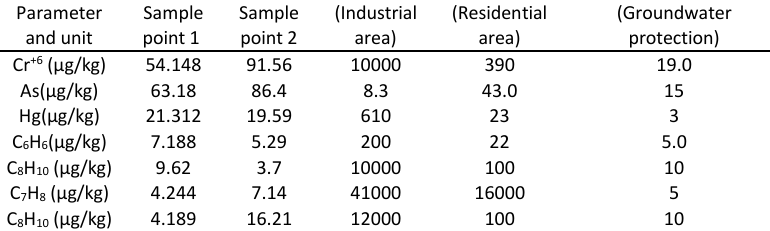
Table 1: Amount of soil pollutants in the selected sampling locations